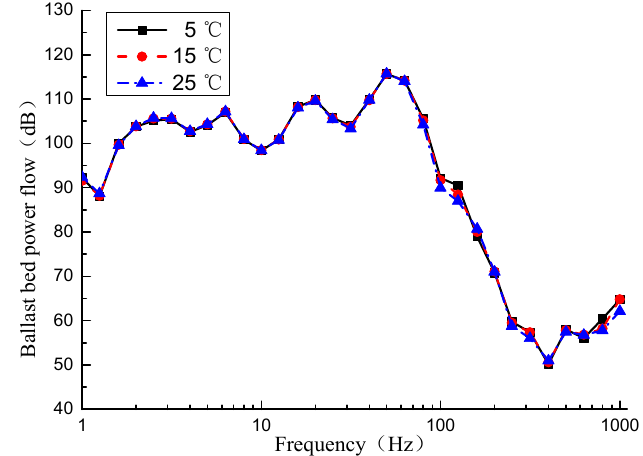
Figure 14. Ballast bed power flow.